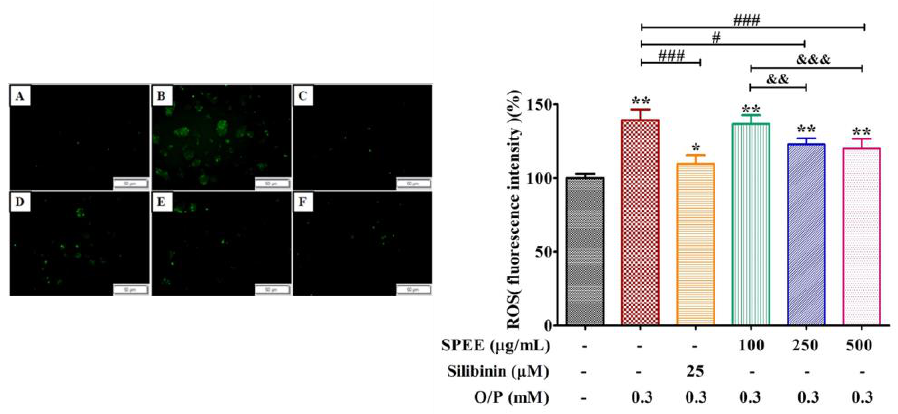
Figure 5. The effects SPEE on O/P-induced intracellular reactive oxygen species (ROS). HepG2 cells were co-treated with 0.3 mM O/P and SPEE at 100, 150 and 500 μ g/mL, respectively, for 24 h. Silibinin (25 μ M) was used as the positive control. Intracellular ROS were assessed using DCFH-DA fluorescence staining and were observed by phase-contrast fluorescence microscopy (left panel, original magnification × 100). ( A ) Control, ( B) O/P 0.3 mM, ( C ) O/P 0.3 mM + Silibinin 25 µ M, ( D ) O/P 0.3 mM + SPEE 100 µ g/mL, ( E ) O/P 0.3 mM + SPEE 250 µ g/mL and ( F ) O/P 0.3 mM + SPEE 500 µ g/mL. Values are expressed as the mean ± SD ( n = 3, right panel). * p < 0.05 and ** p < 0.01 vs. the control group. # p < 0.05 and ### p < 0.001 vs. O/P group. && p < 0.01 and &&& p < 0.001 vs. O/P 0.3 mM + SPEE 100 µ g/mL